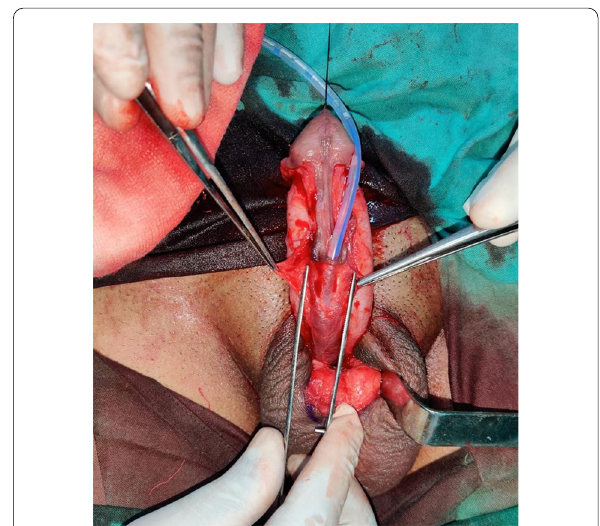
Fig. 1 Intraoperative picture of a 13 years old with mid-penile hypospadias showing poorly developed spongiosum